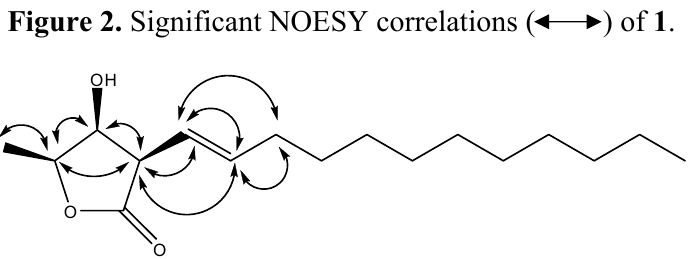
Figure 2. Significant NOESY correlations ( ) of 1